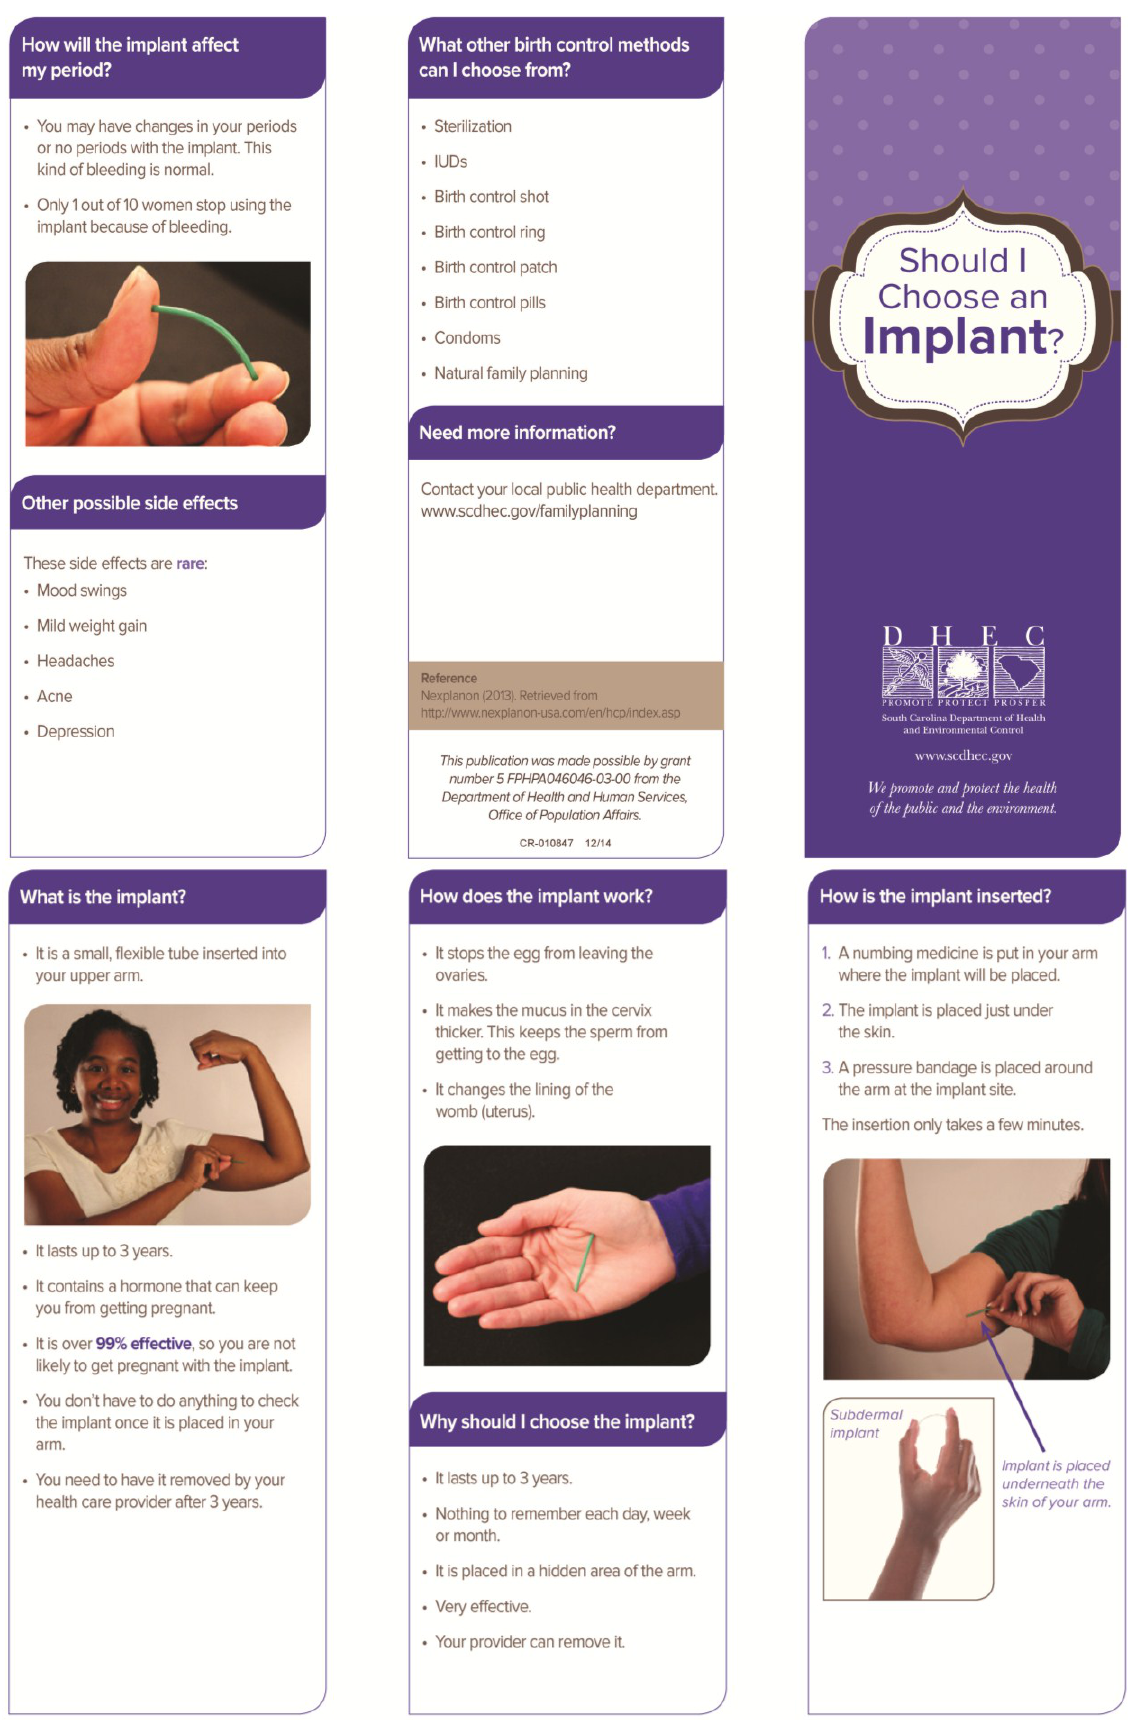
Figure 1. Shared Decision Aid, English Language: “Should I Choose an Implant?”